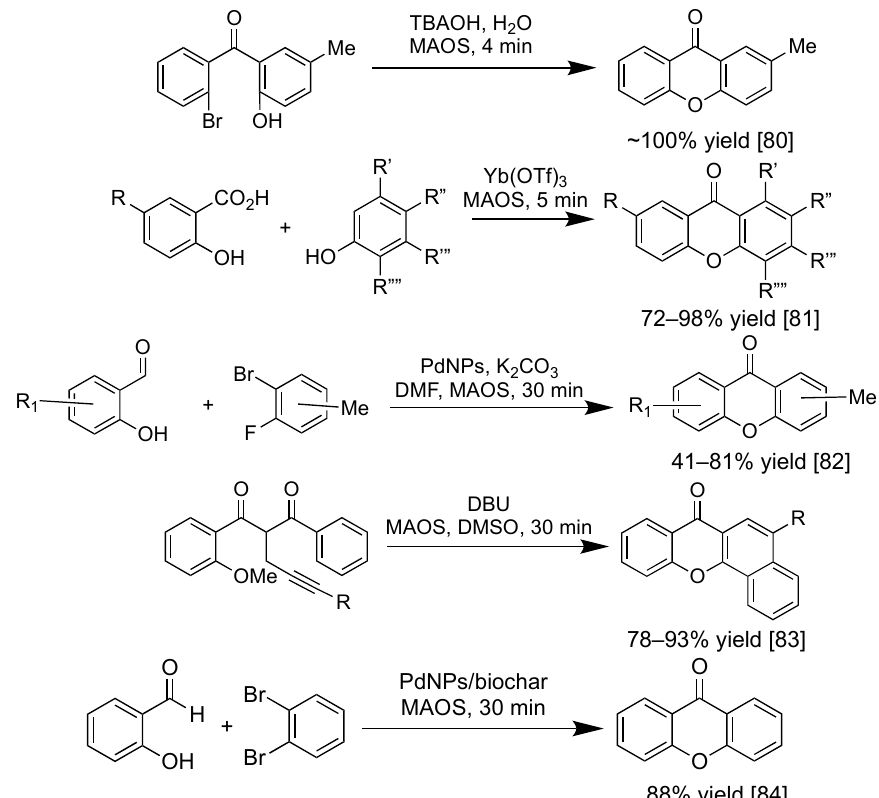
Figure 7. Recent examples of the synthesis of xanthone derivatives using MAOS technique.